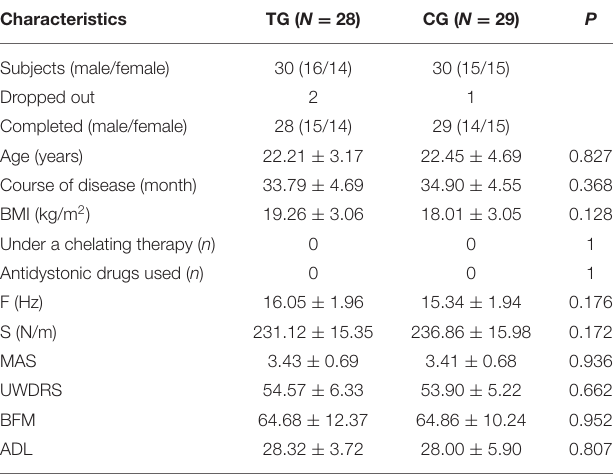
TABLE 1 | Demographic and baseline clinical characteristics of both study groups.